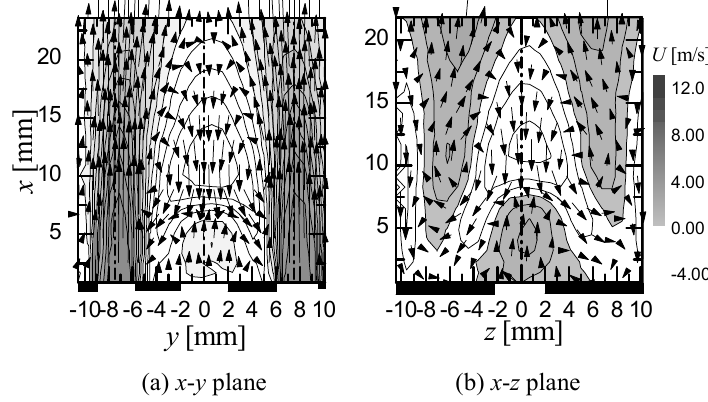
Fig. 5 Streamwise velocity U contours and velocity vectors in R75-s0 case ( Q 1.5L/min and Q = a